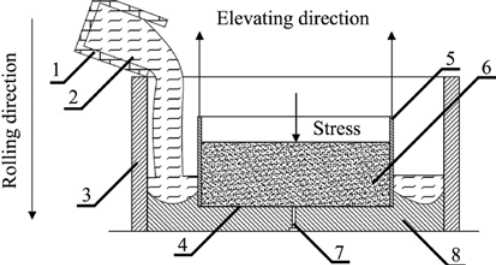
C particle size and mass fraction of the inner layer. Table 2: The B 4